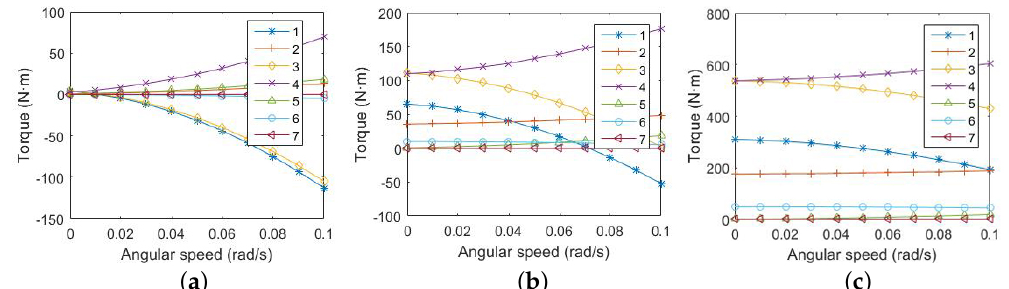
Figure 9. Torque of the simulated manipulator joints: ( a ) the suspension forces balance the gravity in magnitude and direction; ( b ) has a suspension force error of 2%; ( c ) has a suspension force error of